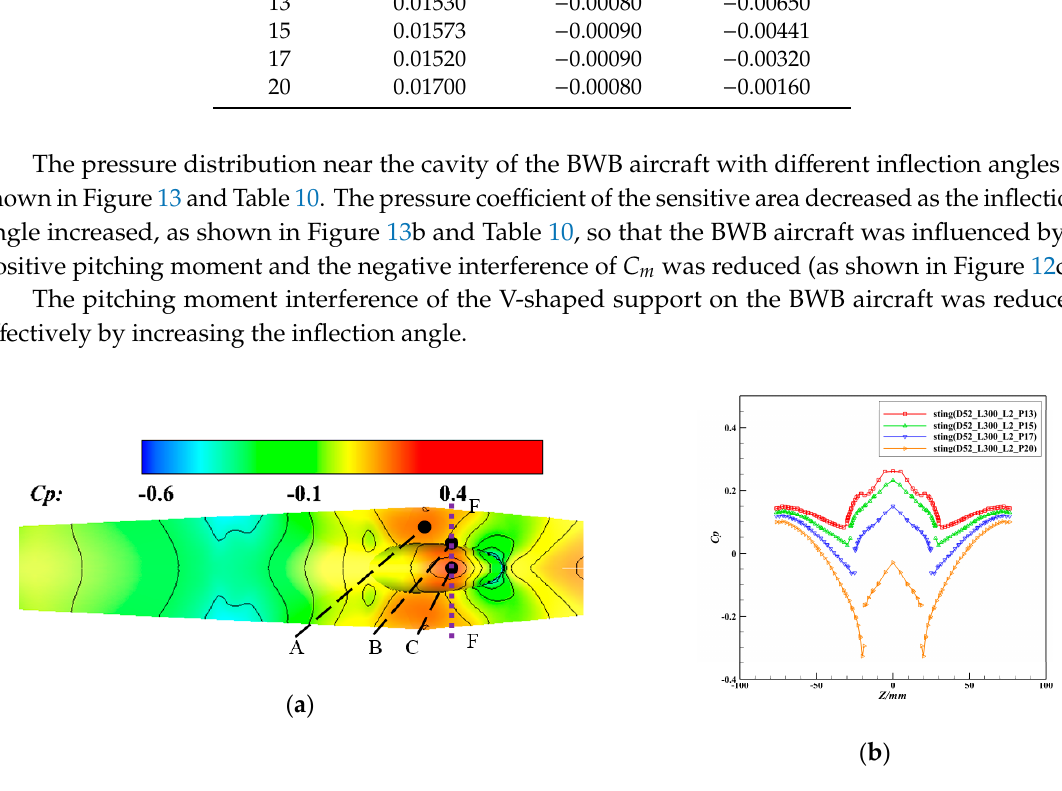
Figure 13. Pressure contour and distribution of the BWB aircraft with different inflection angles (P = 13°/15°/17°/20°, Ma = 0.75, α = 0°): ( a ) pressure contour of the BWB aircraft under the P = 13° condition; ( b ) pressure distribution of profile F-F (position of F-F is shown in Figure 13a). Figure 14. Sensitivity comparison of Δ C m with different geometric parameters ( Ma = 0.75, α = 0°).